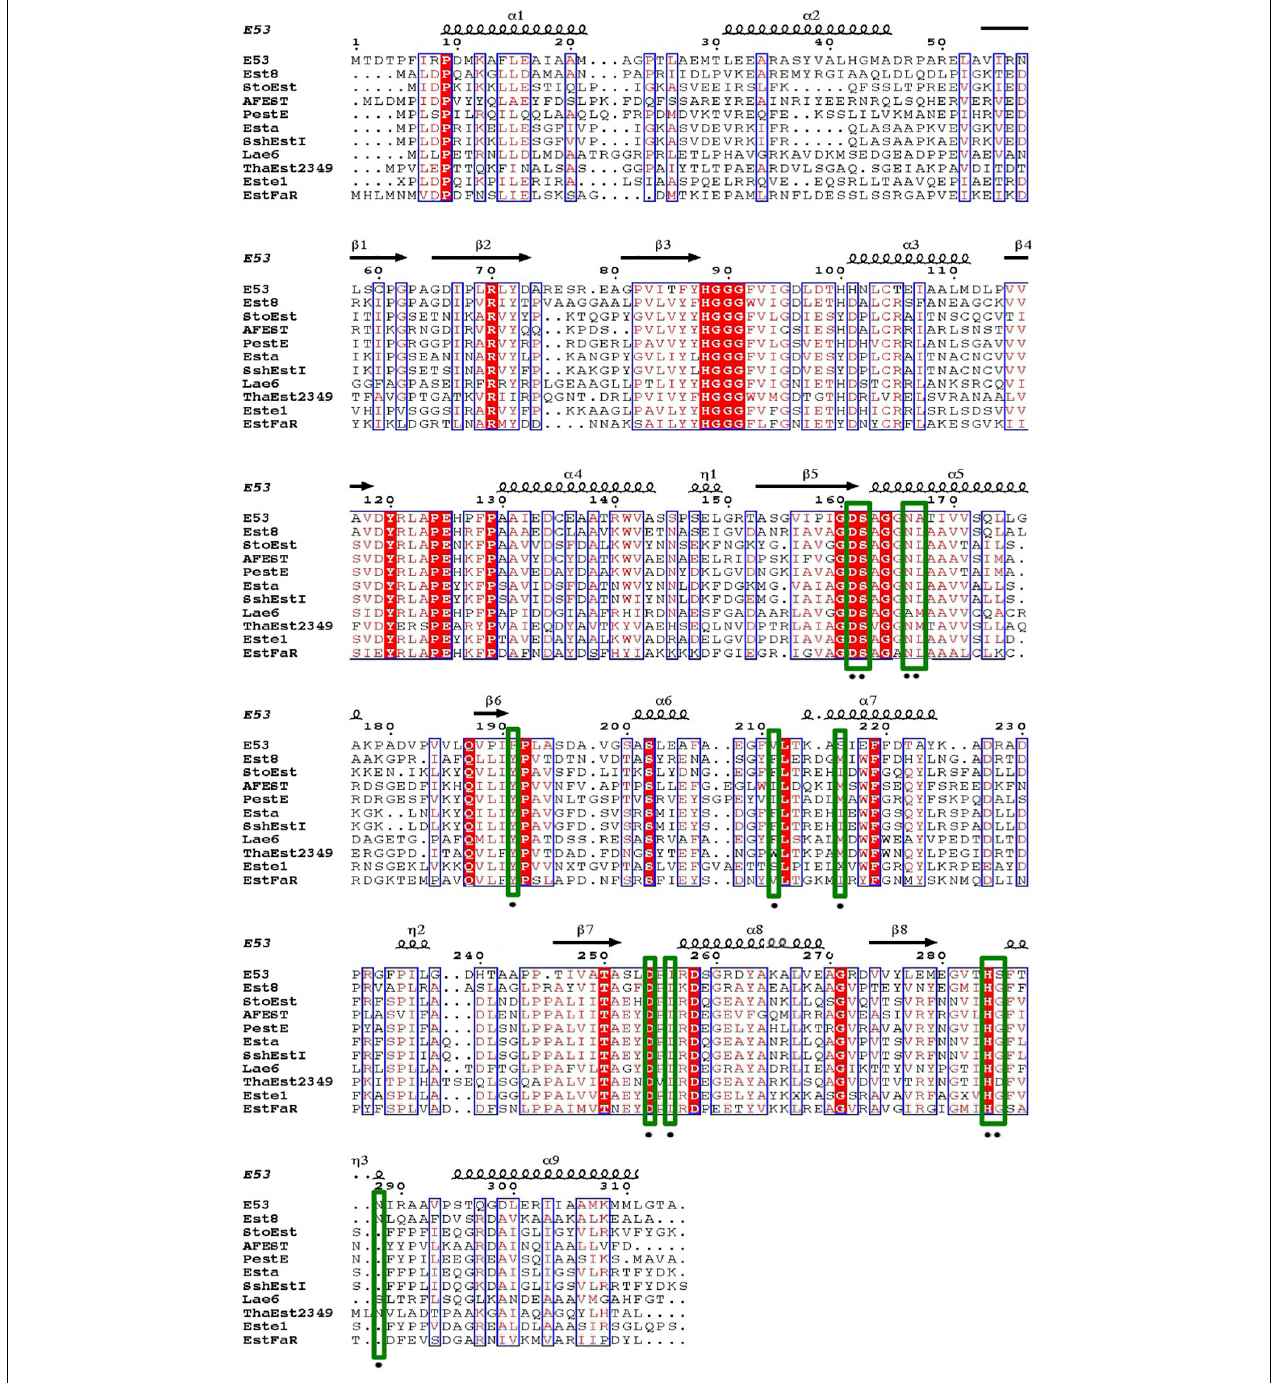
FIGURE 1 | Sequence alignment of E53 and its homologous proteins. Amino acids conserved in all sequences used for alignment were labeled with a red-colored background. Comparative conserved amino acids were labeled with red color. The mutated sites in this study were labeled with green-colored